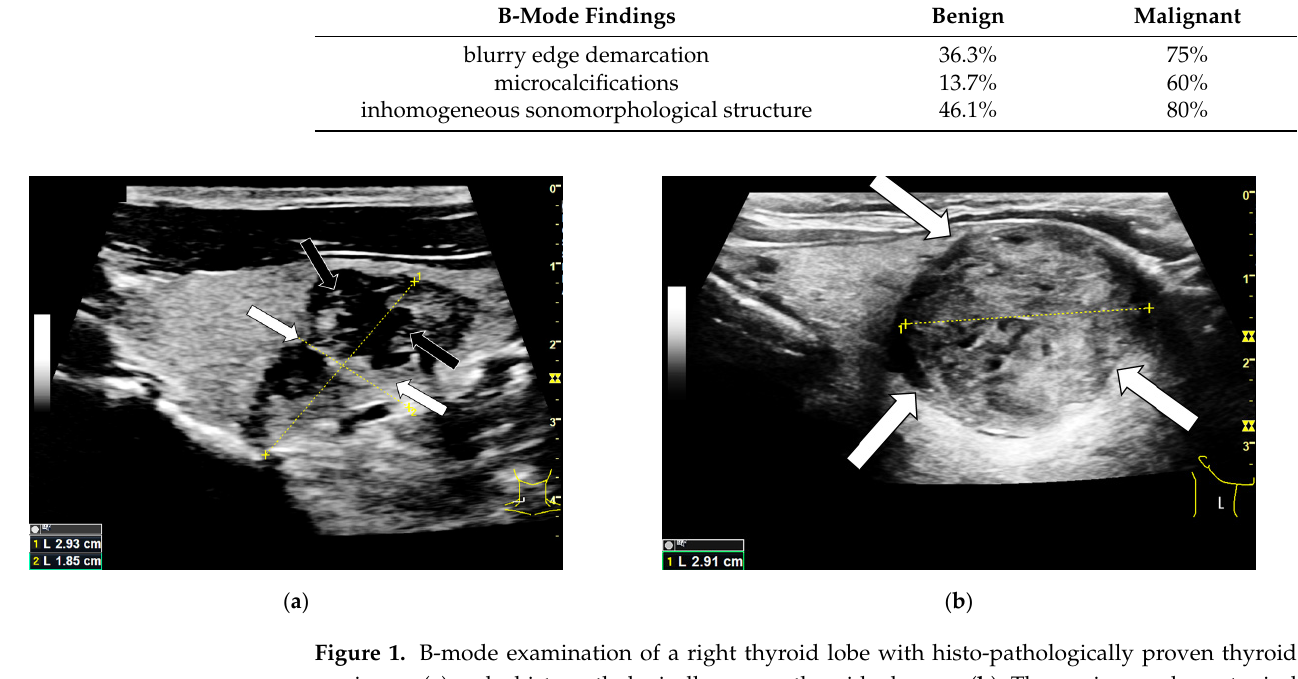
Figure 1. B-mode examination of a right thyroid lobe with histo-pathologically proven thyroid carcinoma ( a ) and a histo-pathologically proven thyroid adenoma ( b ). The carcinoma shows typical malignancy criteria like a blurry edge demarcation (white arrows) as well as an irregular sonomorphological structure and microcalcifications (black arrows). Additionally the majority of the malignoma can be described as hypoechoic compared to the surrounding thyroid tissue. The adenoma shows a clear edge demarcation (white arrows) and a quite homogeneous structure compared to the carcinoma. It is partly isoechoic and partly hyperechoic.